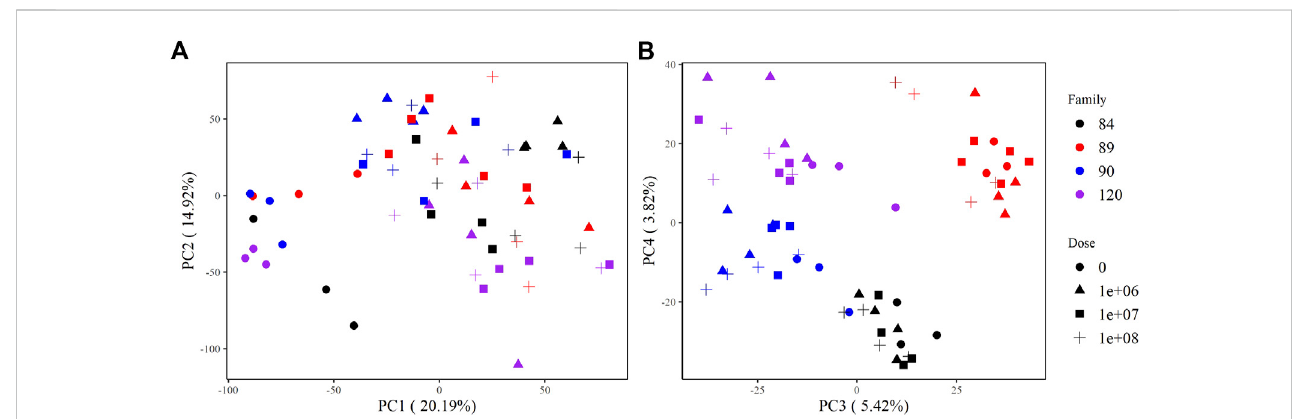
PCA plots of variance stabilizing transformed counts showing global gene expression patterns among samples. (A) PC1 and PC2 group samples by treatment (not dosed or dosed) and (B) PC3 and PC4 group samples by